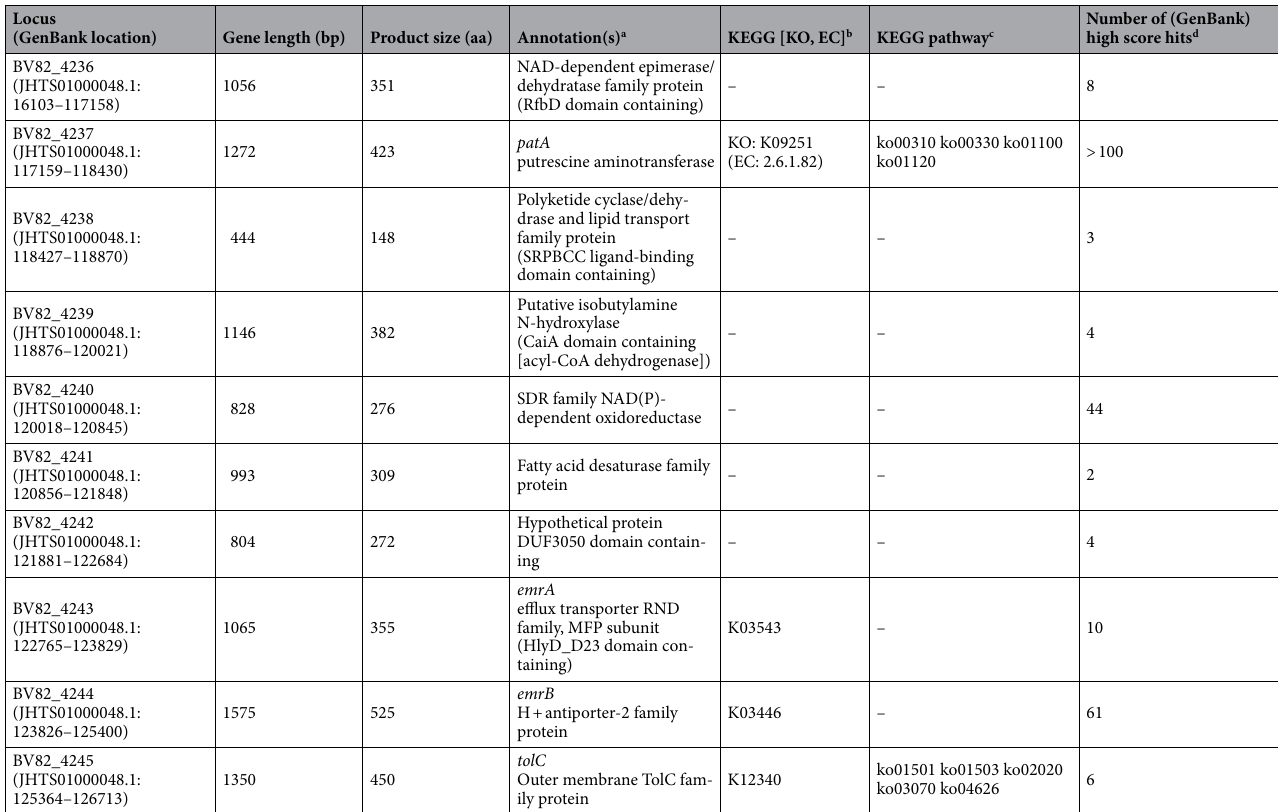
Table 1. P. donghuensis P482 “cluster 17” annotation and features. a Combined data obtained using: